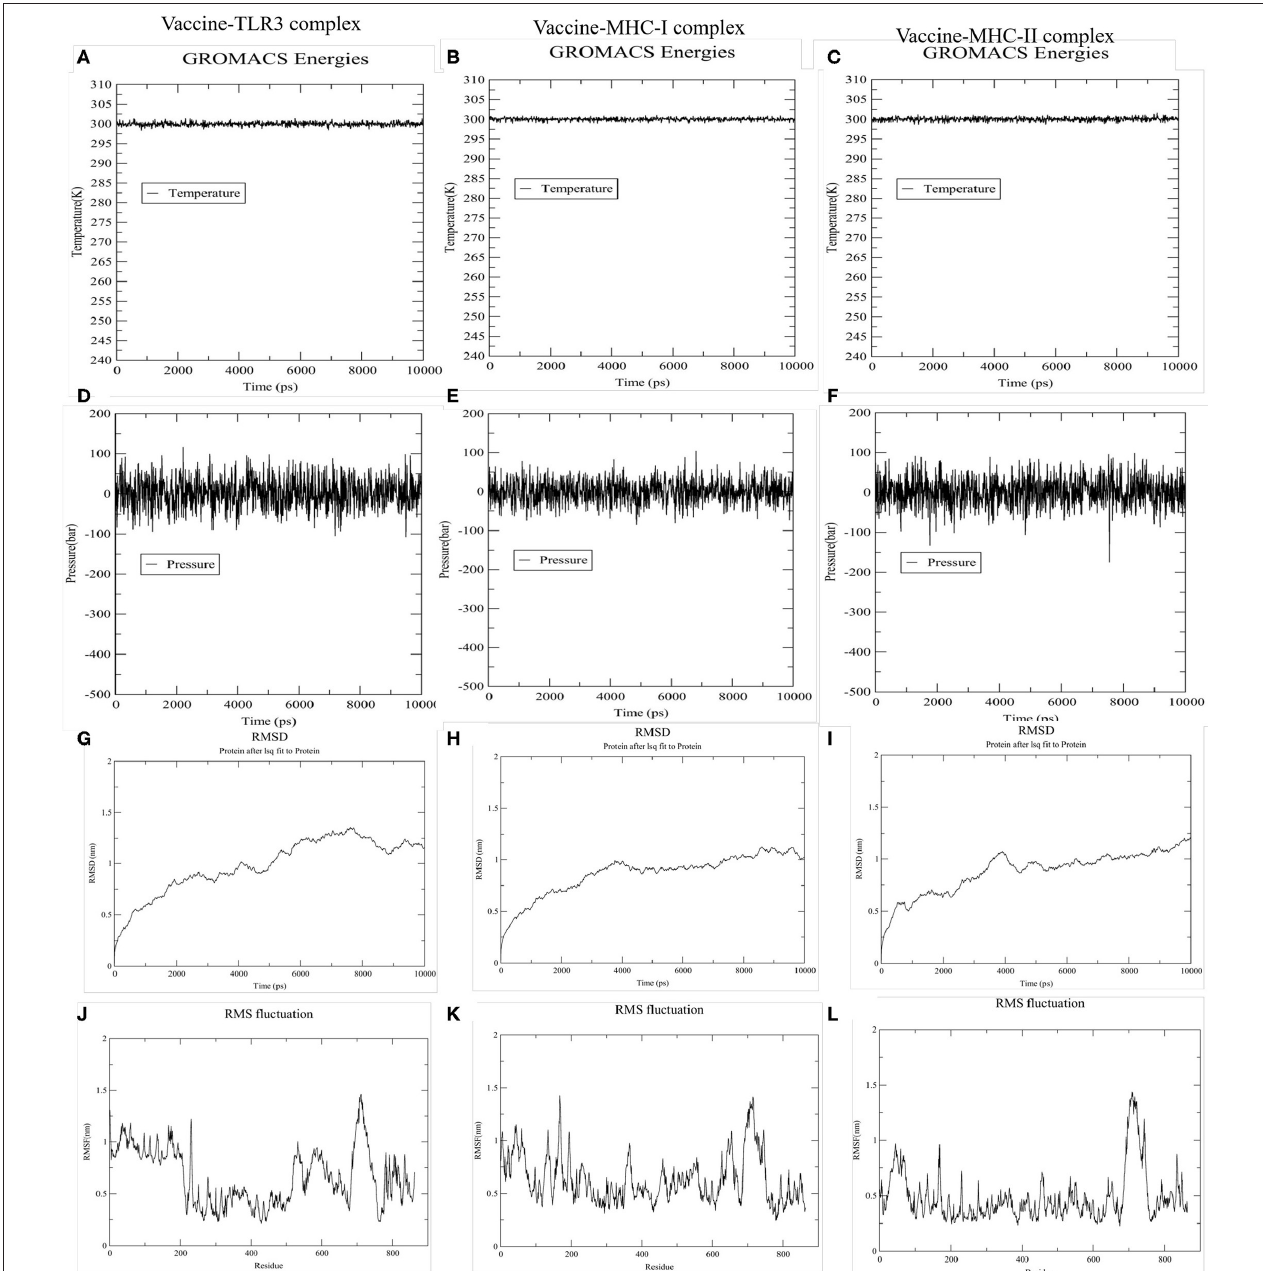
FIGURE 7 | The results of molecular dynamics simulation of vaccine and immune receptors. (A–C) show the equilibration phase ensembles-temperature (constant at 300k for 100 ps) of the complex of vaccine-TLR3, MHC-I, and MHC-II, respectively. (D–F) represent the pressure (displaying fluctuations at 1 bar value for 100 ps) of the complex of vaccine-TLR3, MHC-I, and MHC-II, respectively. (G–I) suggest the RMSD (root mean square deviation) plots reflect the stability between the vaccine and TLR-3, MHC-I, and MHC-II receptor, separately. Whereas, (J–L) RMSF (root mean square fluctuation) reflect the flexibility and fluctuation of the amino-acids residues in the side chain of docked complexes (the complex of vaccine-TLR3, MHC-I, and MHC-II), separately.